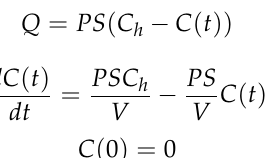
Figure 8. Effect of pH on the permeation of acetic acid, phenol, and caffeine in these mixtures at ( a ) pH 1.1, ( b ) pH 2.9, and ( c ) pH 8.7. Symbols: experimental values; lines: calculated values; ○ : acetic acid; Δ : phenol; (cid:0) : caffeine. Feed concentrations were 0.1 mol/L for acetic acid and phenol and 0.02 mL/L for caffeine.